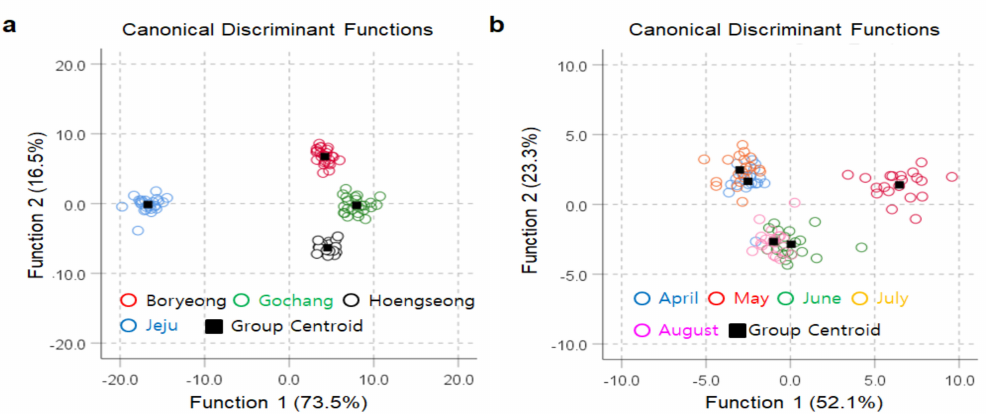
Figure 3. Stepwise discriminant analysis (SDA) for the regional authenticity ( a ) and organic milk (OM)